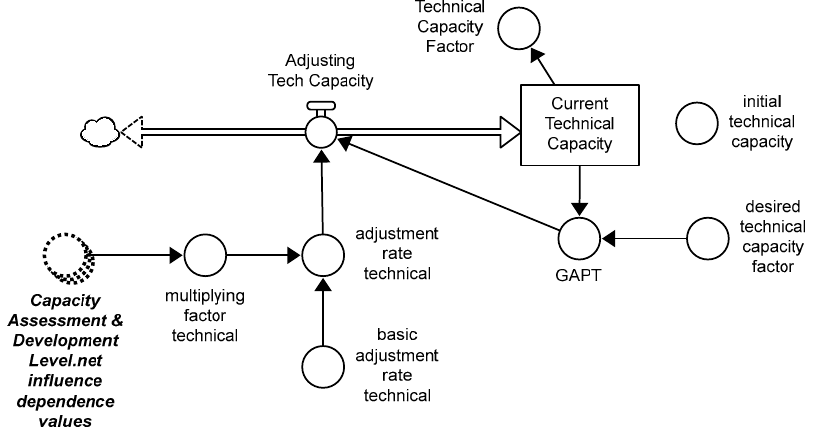
Figure 5. Stock-and-flow diagram of the technical capacity module.